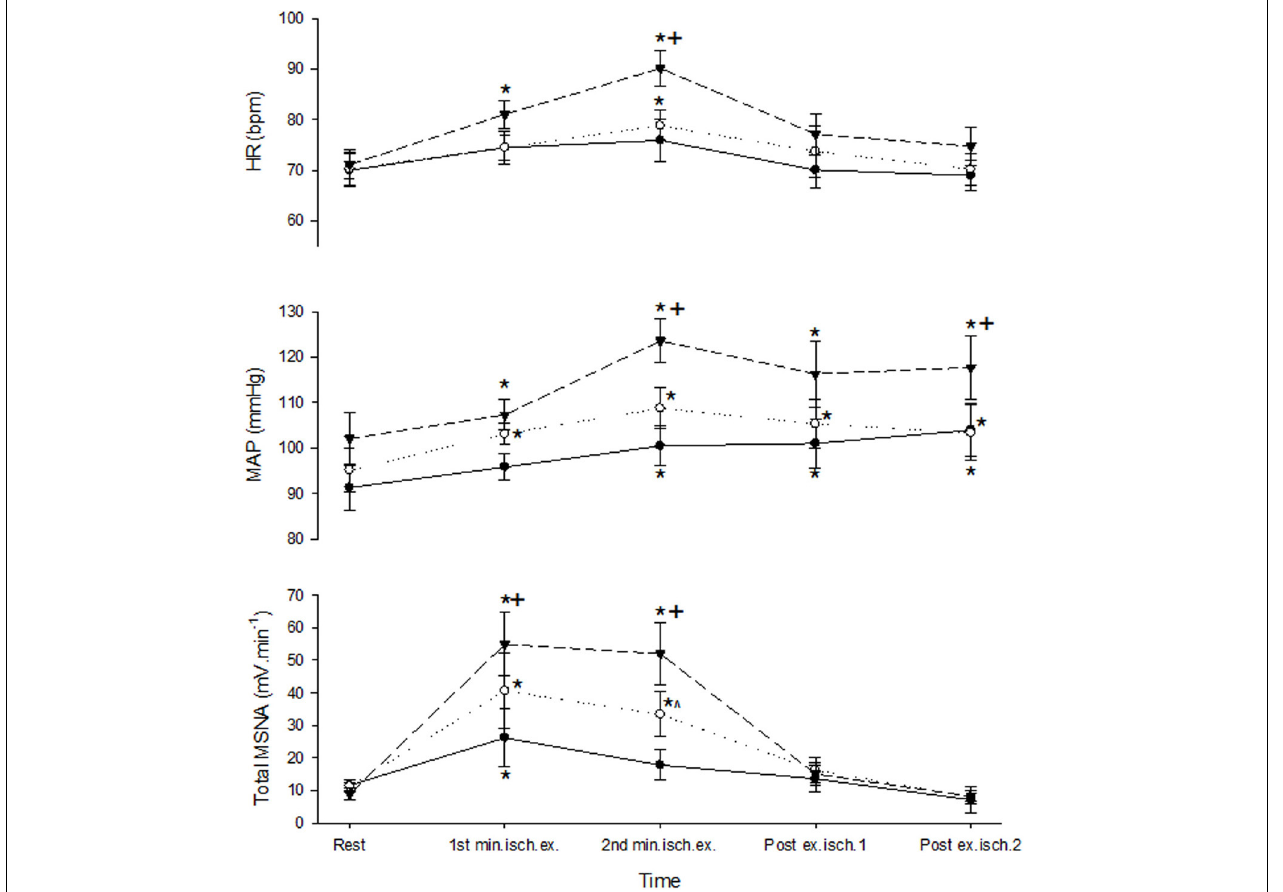
FIGURE 6 | MSNA and cardiovascular responses before, during, and after ischemic contractions at low (closed circle), medium (open circle), and high intensities (triangle). Ischemia was imposed at the start of the second minute of contraction and maintained during recovery. Observations were made at rest and during the first and second minutes of contraction and